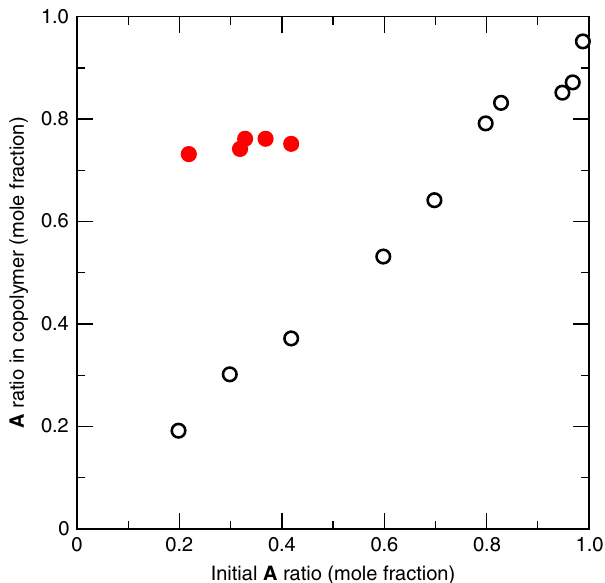
Fig. 6 Copolymer composition plots for the copolymerization of A with S . A series of A ratio in the generated copolymers were plotted against their initial A ratio for the copolymerization of A with S in 1S ( fi lled red circle) and in DMF (open circle). Note that the maximum initial ratio of A is 0.42 in the channels of 1S due to the limitation of introduction amount of A into the